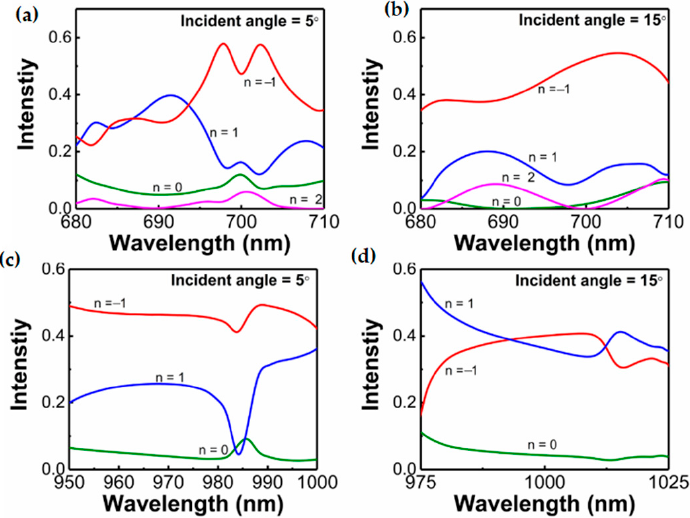
Figure 10. Intensity of each diffraction order when y-polarized light is incident at an angle of ( a ) 5° and ( b ) 15°. Intensity of each diffraction order when x-polarized light is incident at an angle of ( c ) 5° and ( d ) 15°.